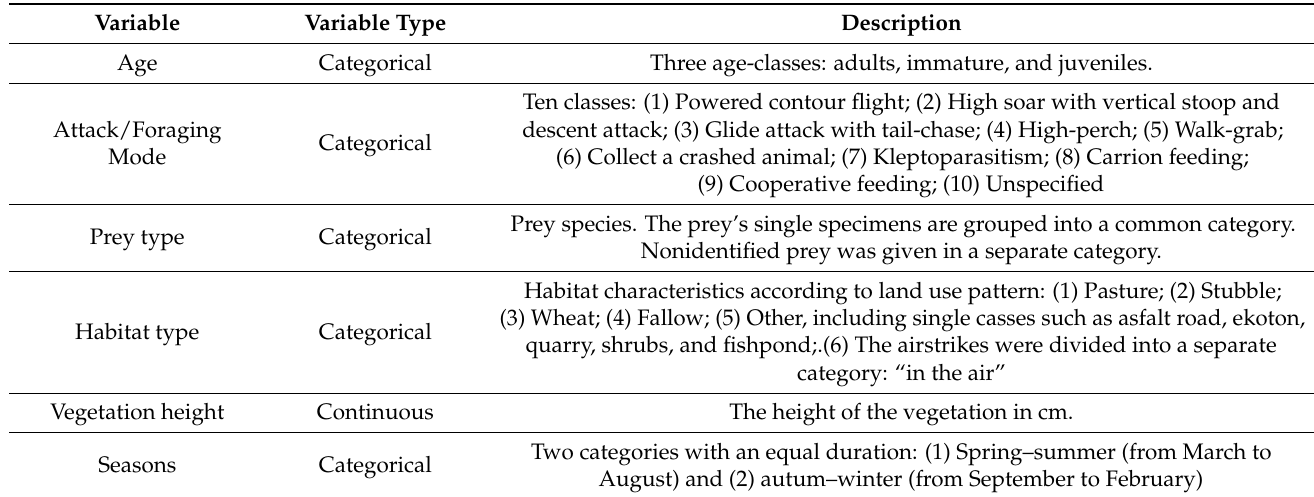
Table 1. Definition of the variables used in models to analyze the attack success and feeding behavior of Eastern Imperial